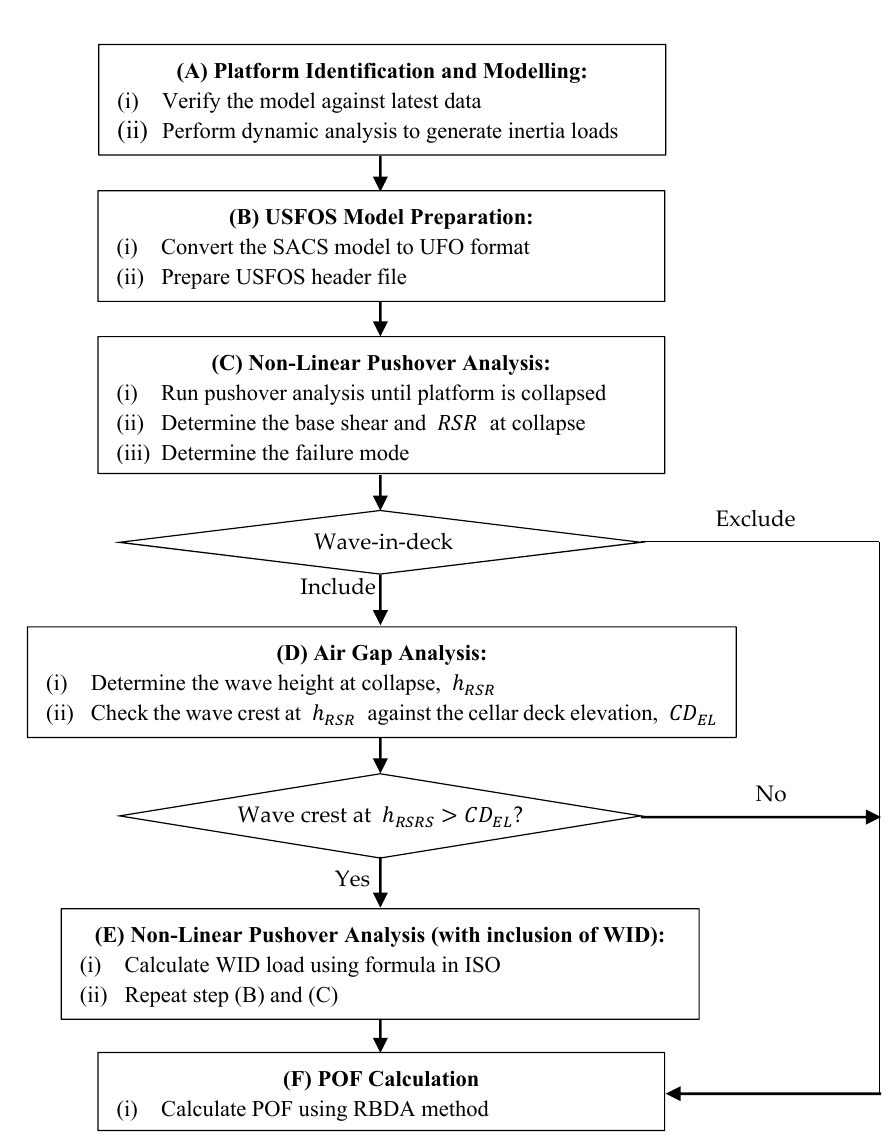
Figure 5. Flowchart of analysis procedure.